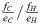
Shading parameters of solutions in the convex hull of Pareto fronts for simplified optimisation study.Horizontal axis shows the ratio fCeC/fHeH of efficiencies and source energy conversion factors for district cooling and heating. Vertical axis depicts depth values for the corresponding group of control points in the shading. Green horizontal steps determine parameter values: y0 = y1 for the lower part of the western fin, y2 = y3 for the upper part of the western fin, y4 for the joint of the western fin and the overhang, y5 = ⋯ = y9 for the internal part of the overhang, y10 for the joint of the overhang and the eastern fin, and y11 = ⋯ = y14 for the remaining part of the eastern fin. The steps are stretched between the values of ratios fCeC/fHeH for which the corresponding shading in the convex hull has the minimum total equivalent source energy demand. Gray vertical line is placed at r = 0.3038, which corresponds to current efficiencies and source energy conversion factors for district cooling and heating in USA [55]. Red line shows fitted arctangent function for depths of each control point group.